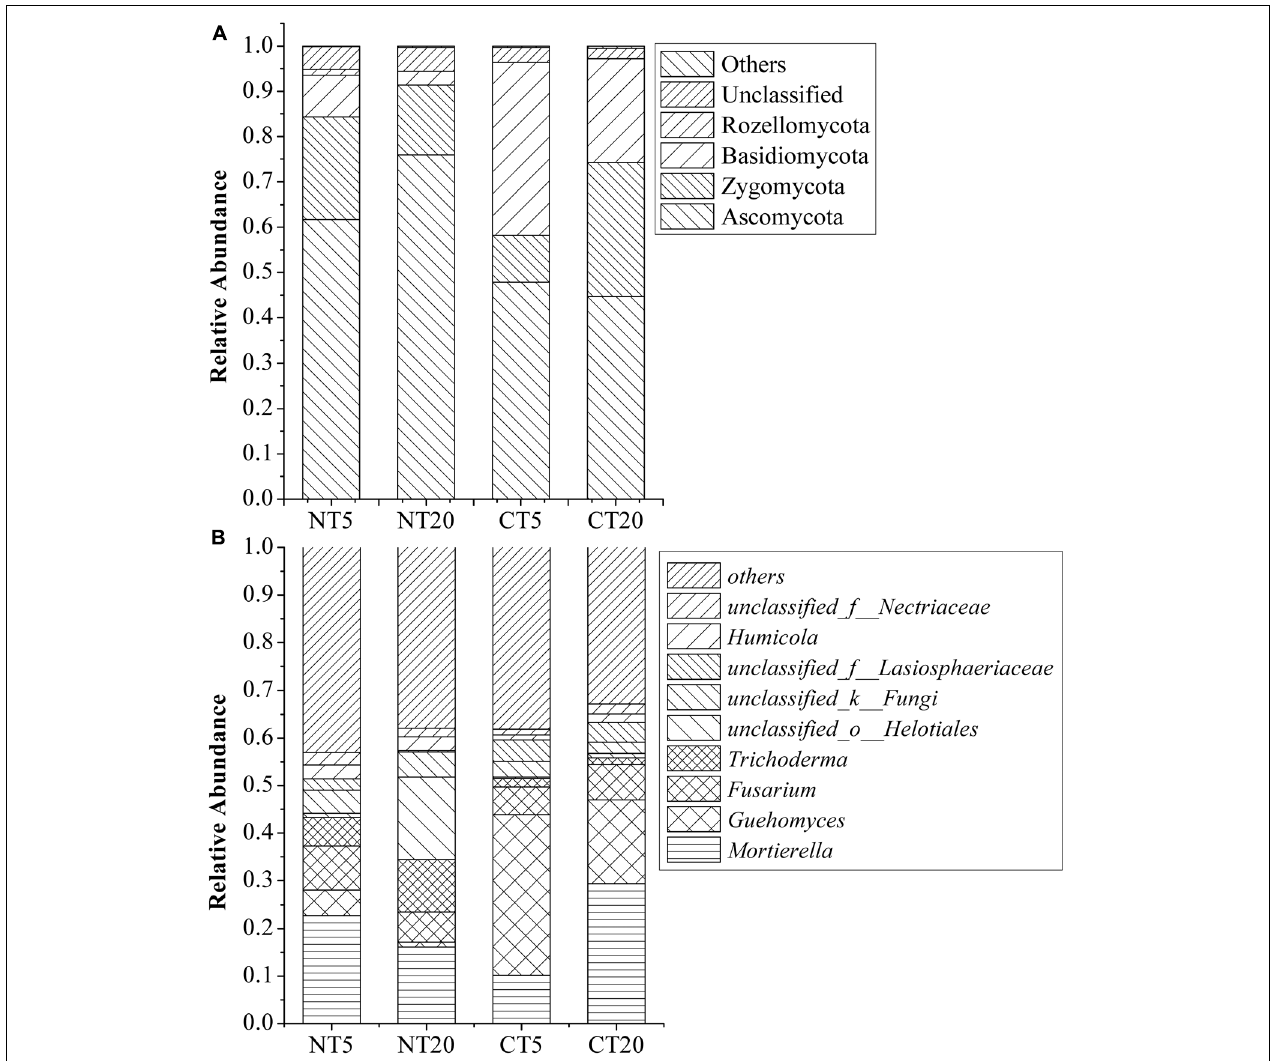
FIGURE 1 | Relative abundance of predominant fungal at phylum (A) and genus (B) levels under NT and CT.